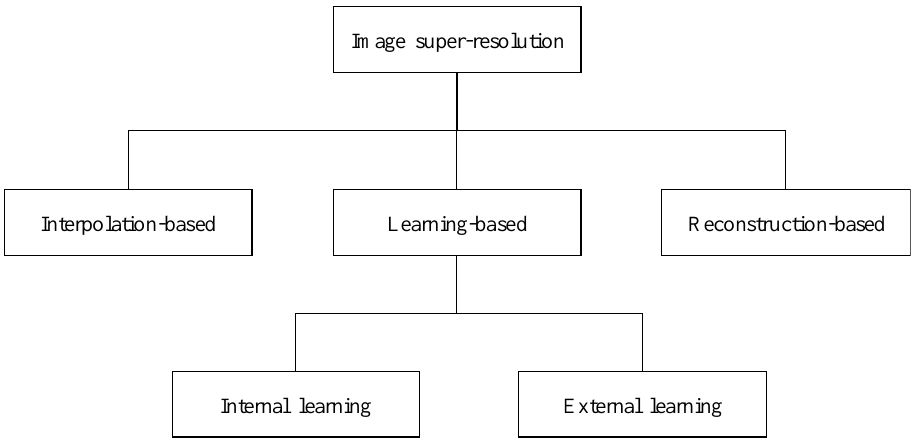
Figure 7. Applications of the image super-resolution technique. Figure 8. Classification of the approach to image super-resolution.